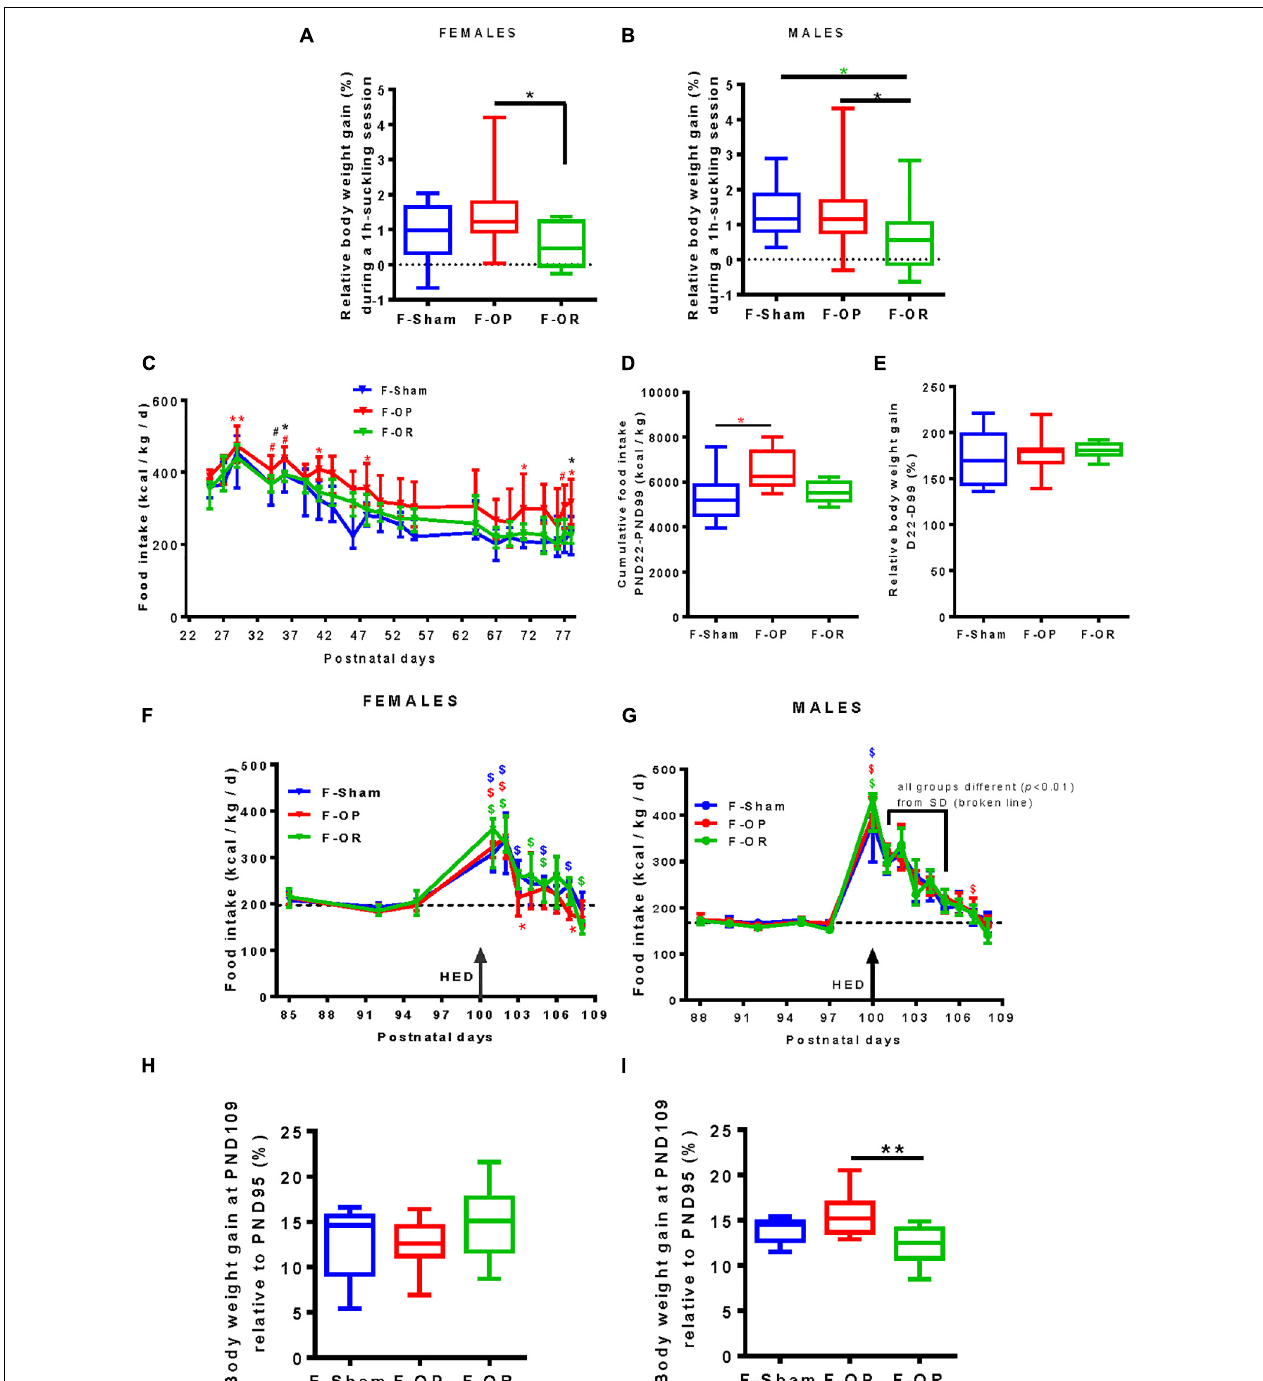
FIGURE 6 | Food intake at different periods of life. Hourly milk intake of female (A) ( n = 16–19) and (B) male pups ( n = 17–20) at PND15 estimated by the body weight gain after suckling divided by initial body weight. Daily (C) and cumulative (D) food intake and (E) relative weight gain on SD after weaning in females ( n = 7–9). (F,G) Daily caloric intake and (H,I) relative weight gain during the first 10 days of HED (PND100–109) in females (left, n = 7–8) and males (right, n = 9–11). Panels (A,B,D,E,H,I) data are medians with range (min–max), * p < 0.05, ** p < 0.01, Kruskal–Wallis and post hoc Dunn’s tests. (C,F,G) Data are medians and interquartile range, * p < 0.05, ** p < 0.01, # 0.05 < p < 0.06; “*” indicates differences (“ # ” tendency) between F-OP and F-Sham; “*” indicates differences (“ # ” tendency) between F-OP and F-OR. (F,G) $ , $ , $ p < 0.05 indicate difference from basal SD consumption (dotted line, median of the three groups) in each group, Wilcoxon signed rank